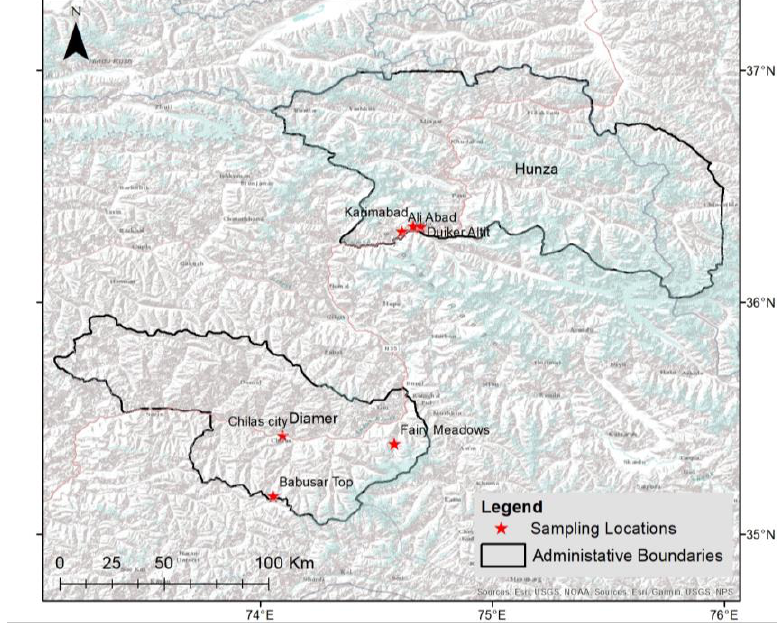
Fig. 1. Map of Gilgit-Baltistan